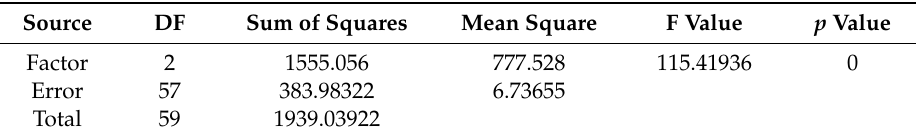
Table 5. ANOVA for ARPD of the compared algorithms in Table 4.